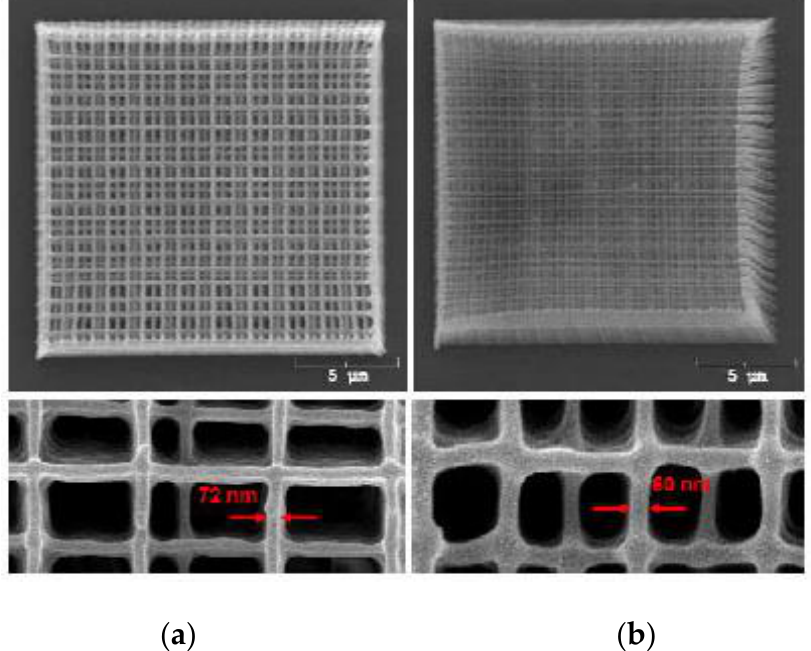
Figure 23. Nanoscale woodpile structures printed with MPP showing ( a ) laser excitation of 0.6 µ W and a resultant beam thickness of 72 nm, and ( b ) laser excitation of 0.45 µ W and a resultant beam thickness of 60 nm [126].